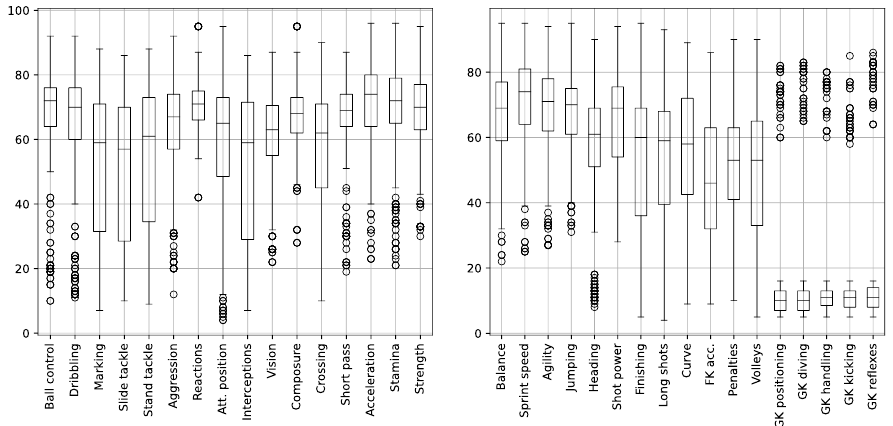
Figure 3. Distributions of features related to players’